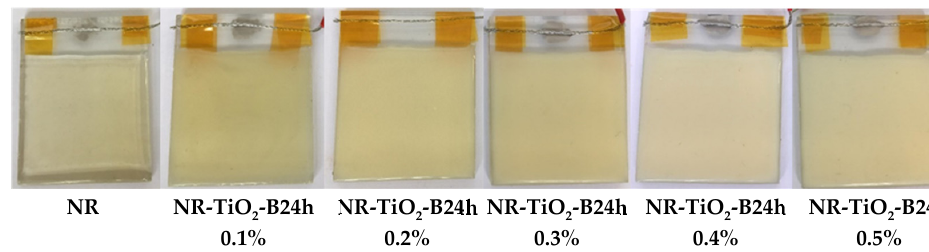
Figure 6. Digital photograph of the NR and NR-TiO 2 -B24h 0.1–0.5%wt.